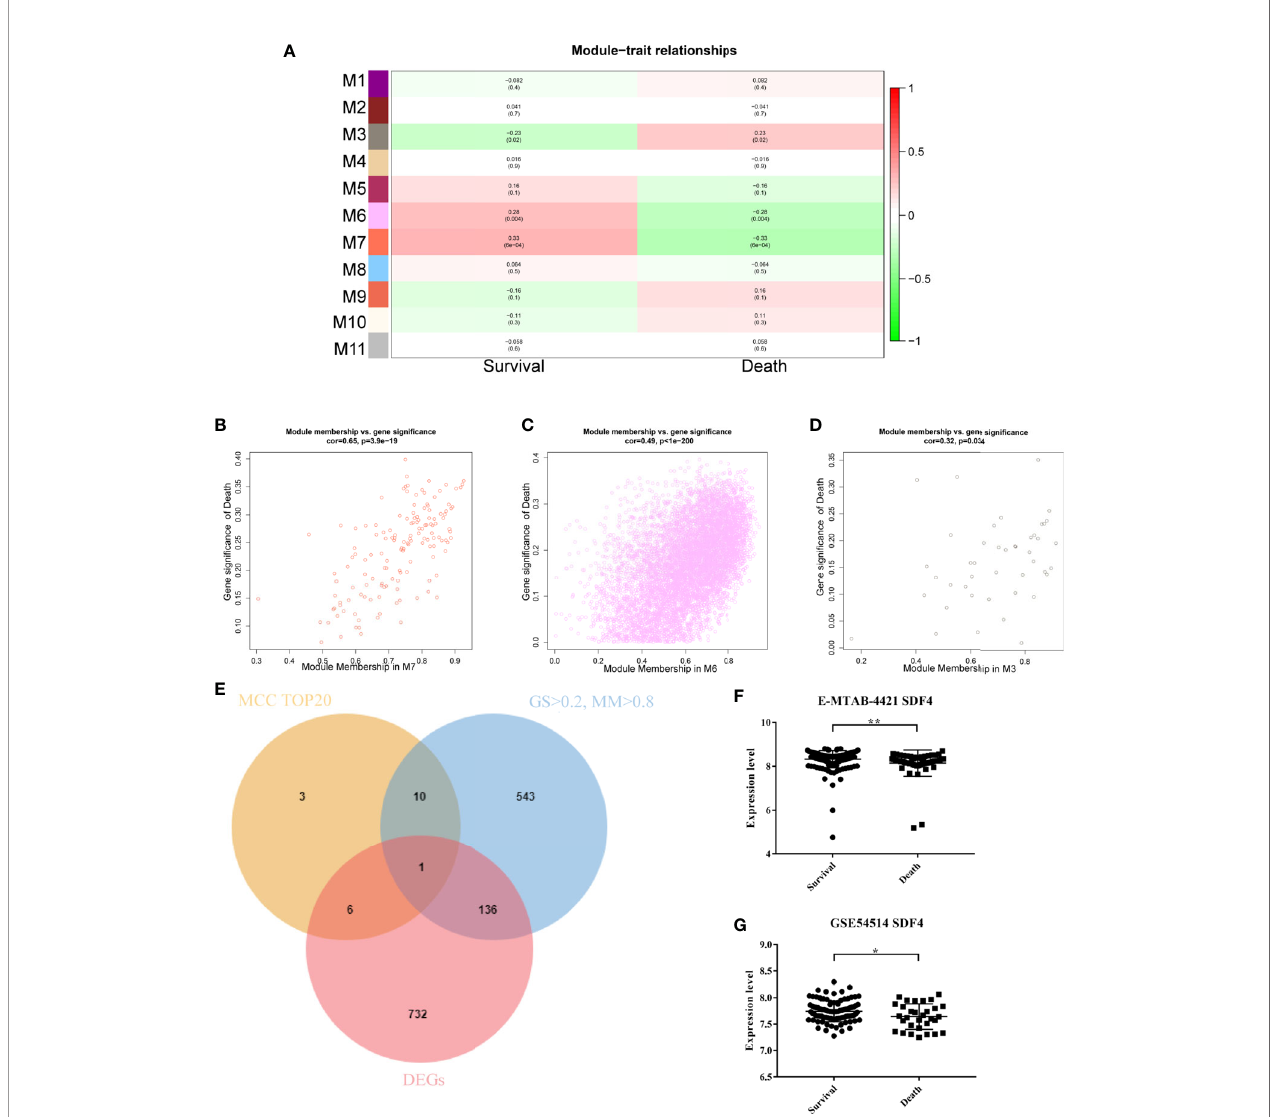
FIGURE 2 | (A) Module-trait associations. Each row corresponds to a module eigengene, and each column corresponds to a trait. Each cell contains the corresponding correlation and P -value. The table is color-coded by correlation according to the color legend. (B) Correlation between module membership and gene signi fi cance in the M7 module. (C) Correlation between module membership and gene signi fi cance in the M6 module. (D) Correlation between module membership and gene signi fi cance in the M3 module. (E) Identi fi cation of the hub gene in the intersection of MCC TOP20, DEGs, and GS > 0.2, and MM > 0.8. (F) SDF4 expression in survivors compared to non-survivors in the validation dataset E-MTAB-421. (G) SDF4 expression in survival compared to death in validation dataset GSE54514. **p < 0.01, *p <